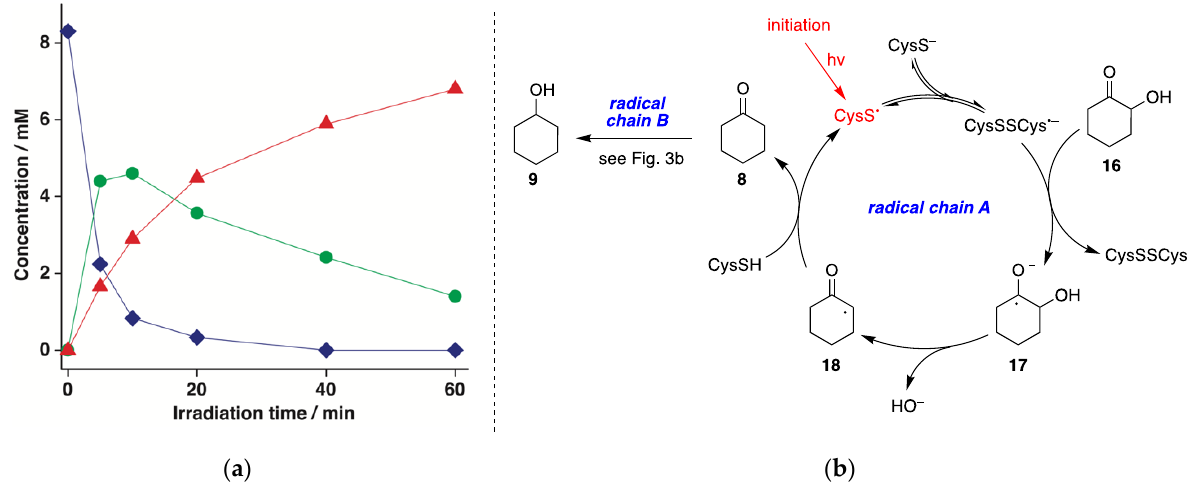
Figure 5. ( a ) Concentration of 16 ( (cid:7) ), 8 ( • ), and 9 ( (cid:78) ) vs. irradiation time for the photolysis of N 2 -saturated 2- hydroxycyclohexanone ( 16 ) aqueous solutions (8.3 mM) containing CysSH (18.3 mM), pH adjusted to 10.6, at 42 ± 1 ◦ C; ( b ) Proposed reaction mechanism involving dual radical chain reactions A and